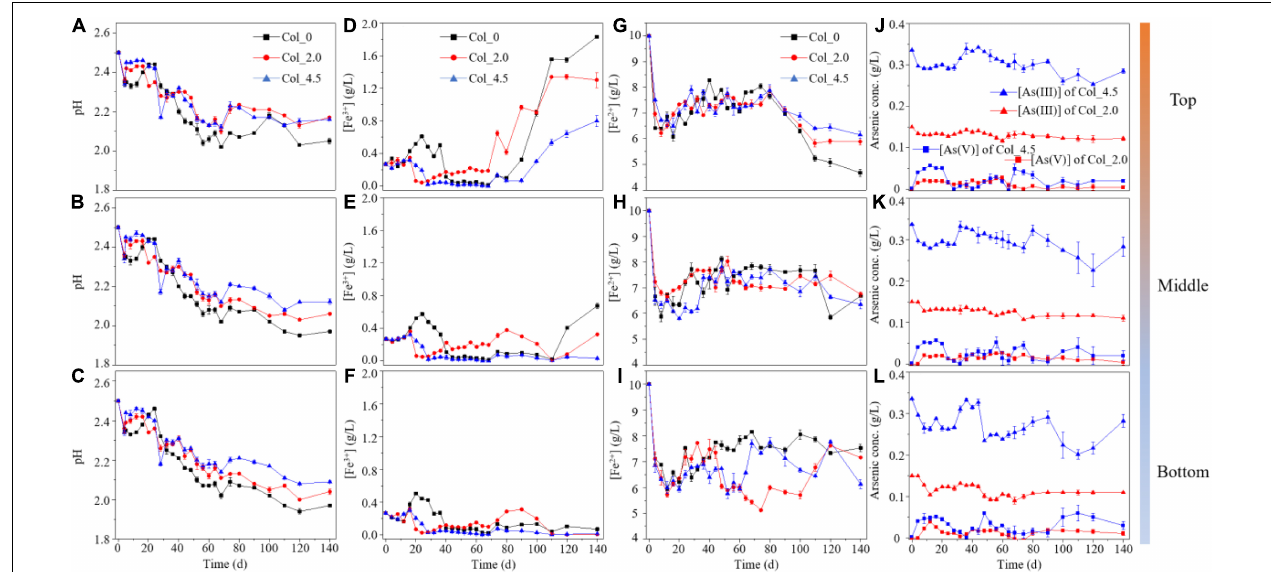
FIGURE 2 | The curves of pH (A–C) , [Fe 3 + ] (D–F) , and [Fe 2 + ] (G–I) in the solutions at the top (A,D,G,J) , middle (B,E,H,K) , and bottom (C,F,I,L) of the water columns during cultivation without (Col_0) and with additions of 2.0 mM (Col_2.0) and 4.5 mM (Col_4.5) As(III), and the curves of [As(III)] and [As(V)] (J–L) with additions of 2.0 and 4.5 mM As(III). Error bars represent SD, n = 3.